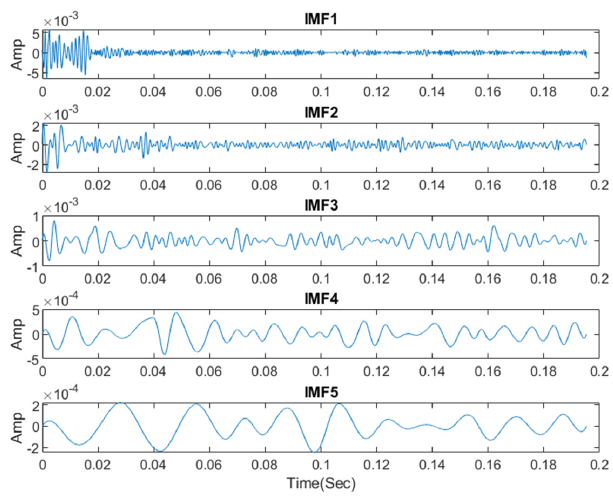
Figure 15. Dominant IMFs after Empirical Mode Decomposition (EMD) operation for A90C1 Serviceable Pole 1 using improved HHT.